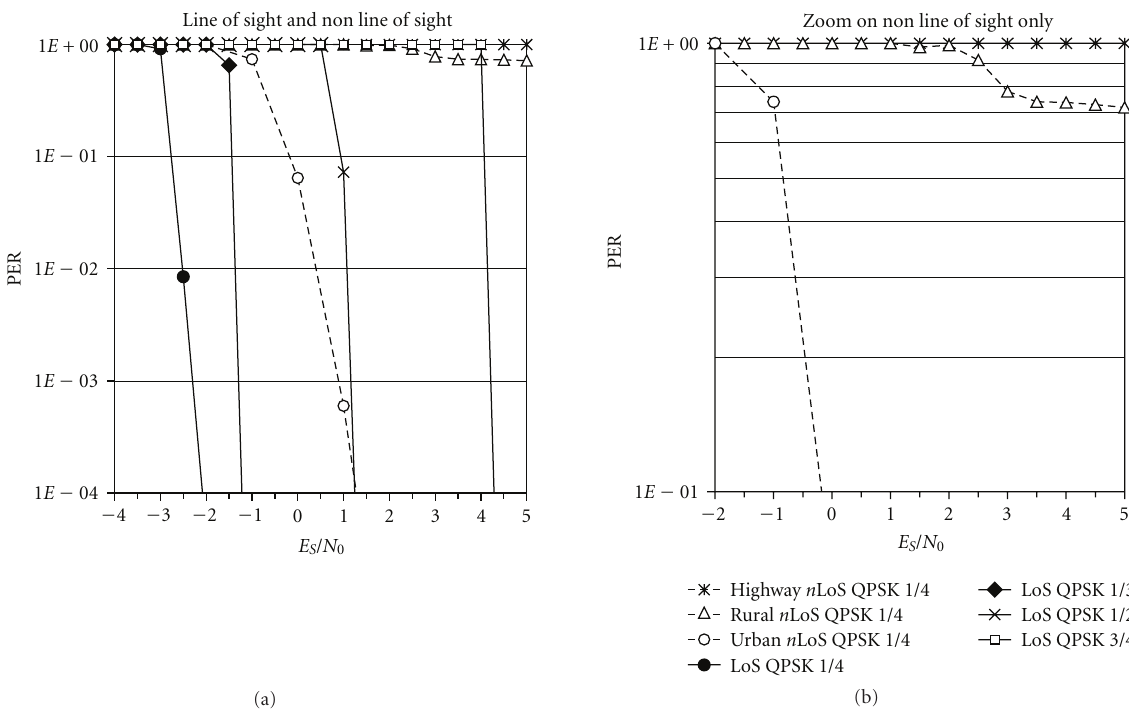
Figure 2: Packet error rate for mobile DVB-S2 in LoS and shadowed